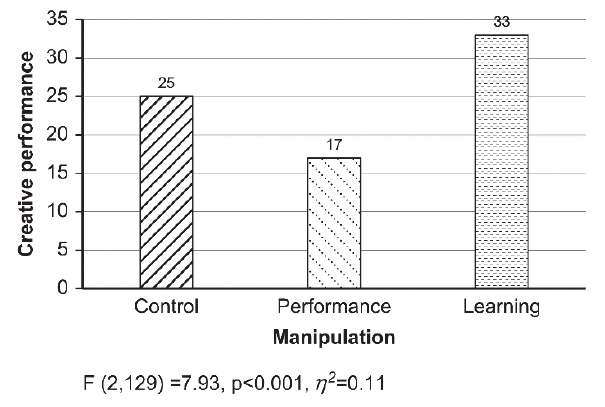
Figure 2. Means of creative performance as a function of motivational orientation (source: created by